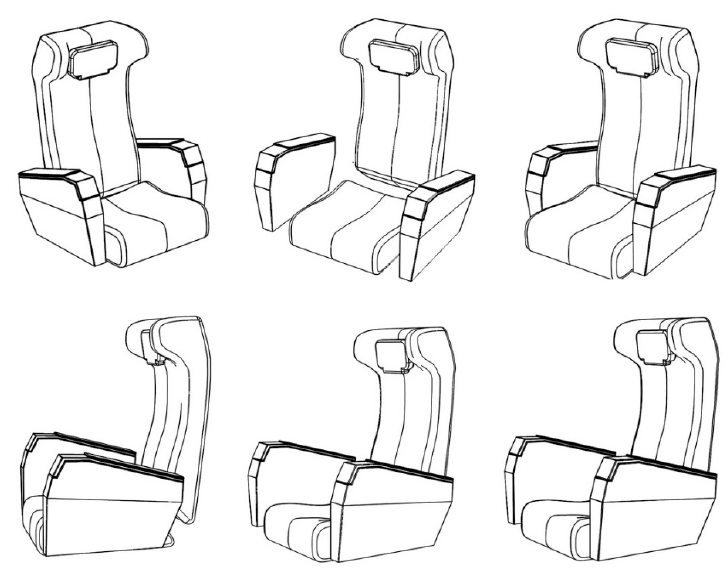
Figure 8. The form experimental sample of high-speed train No. 2 of the first group.